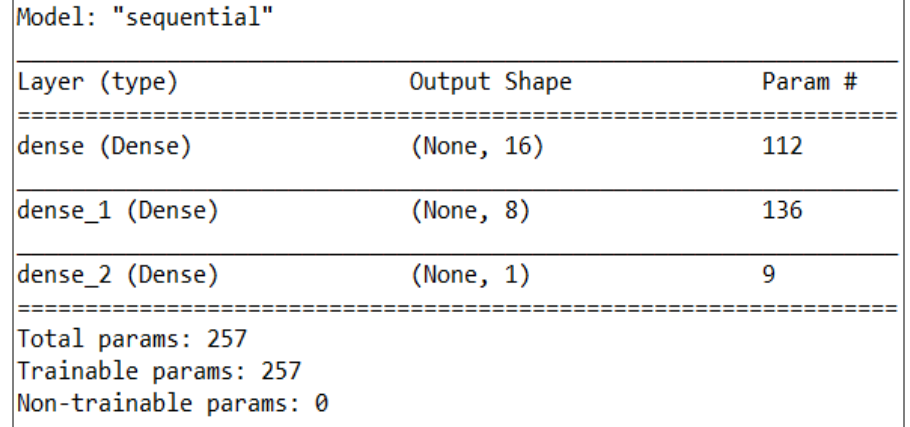
Figure 7. Defined multilayer perception model. Source: Own elaboration.